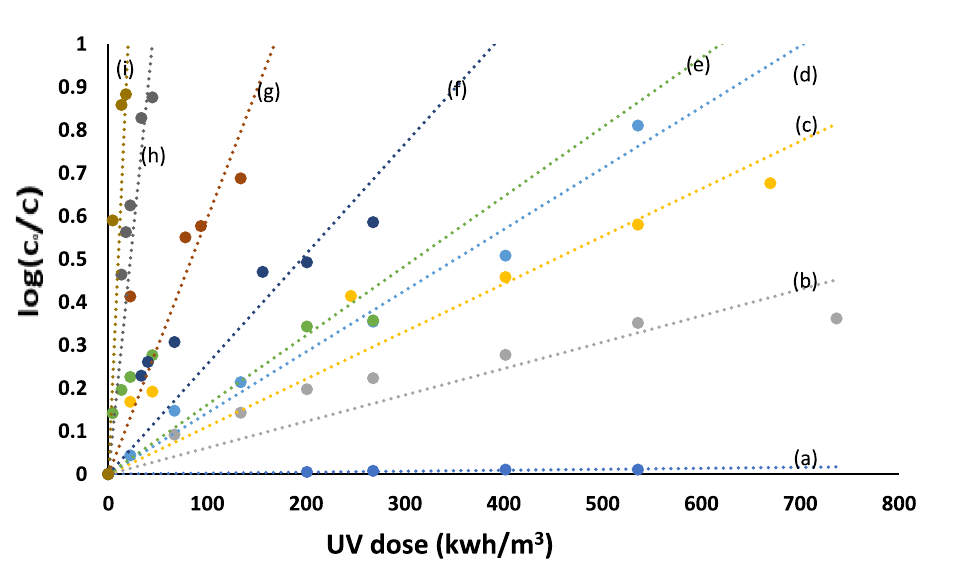
Figure 13. Plot of log (C o /C) versus UV dose (kwh/m 3 ) for degradation of (1.0 × 10 -4 mol/ L) Acid Red 37 dye in: ( a ) absence of catalysts, ( b ) presence of ZnO, ( c ) presence of TiO 2 , ( d ) presence of ZnO–TiO 2 mixture, ( e ) presence of 0.02 g/L chitosan-based Ag NPs, ( f ) (ZnO–TiO 2 ) and 0.02 g/L Ag NPs, ( g ) (ZnO–TiO 2 ) and 0.06 g/L AgNPs, ( h ) (ZnO–TiO 2 ) and 0.12 g/L Ag NPs, ( i ) (ZnO–TiO 2 ) and 0.18 g/L